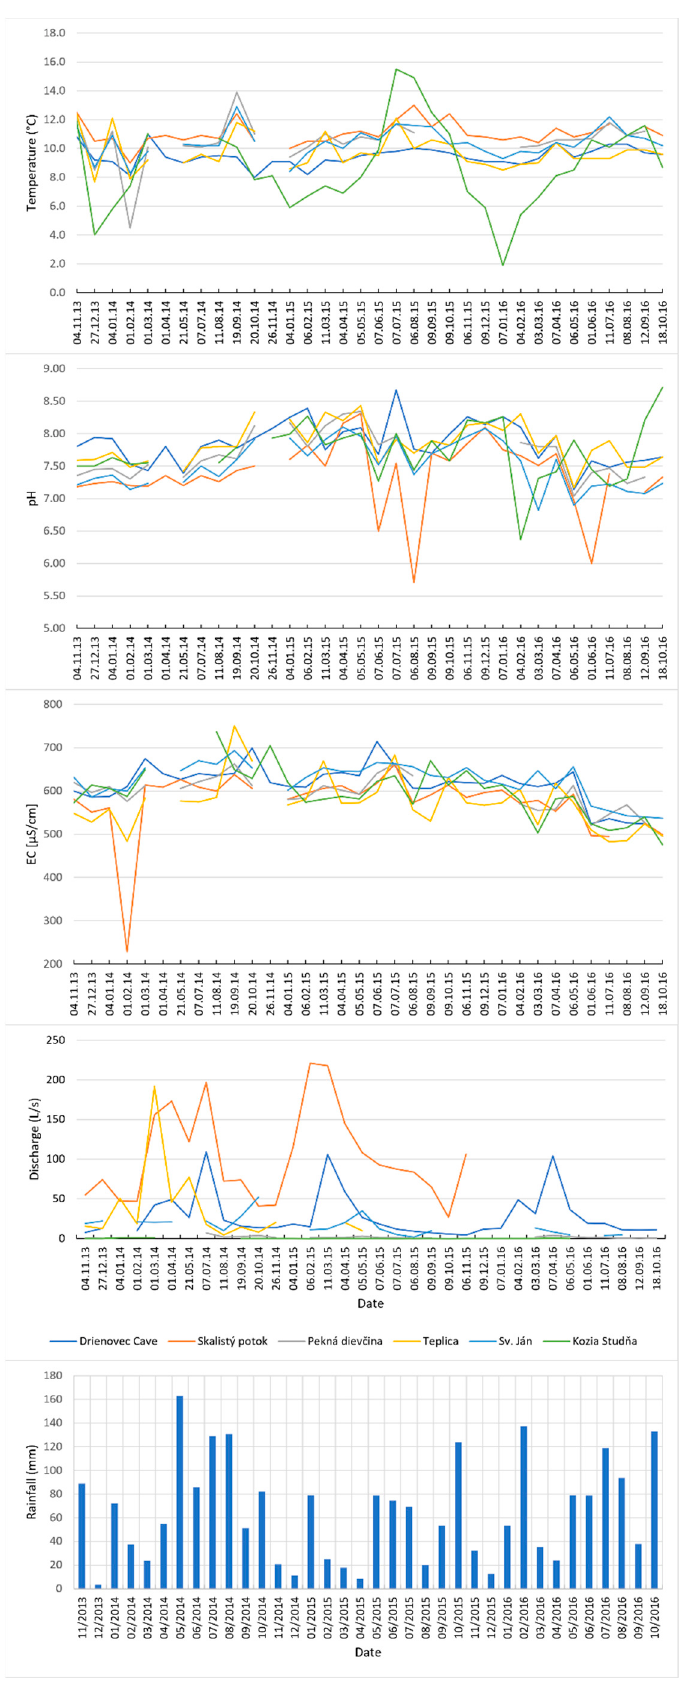
Figure 5. Main water parameters—temperature, pH, electrical conductivity, discharge and rainfall.